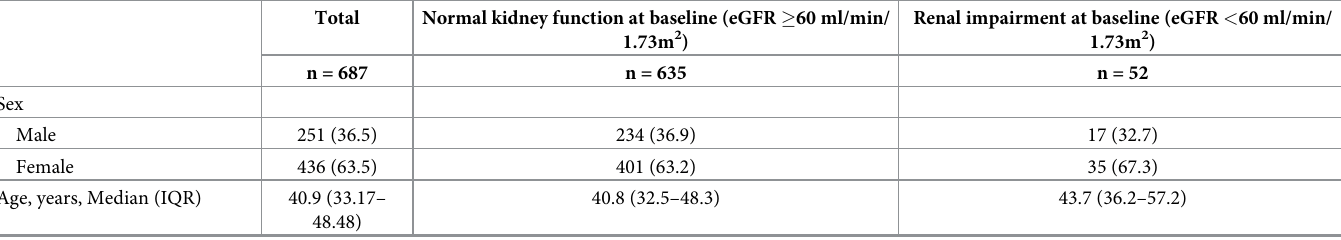
Table 1. Characteristics of the 687 patients at the time of switch to second-line